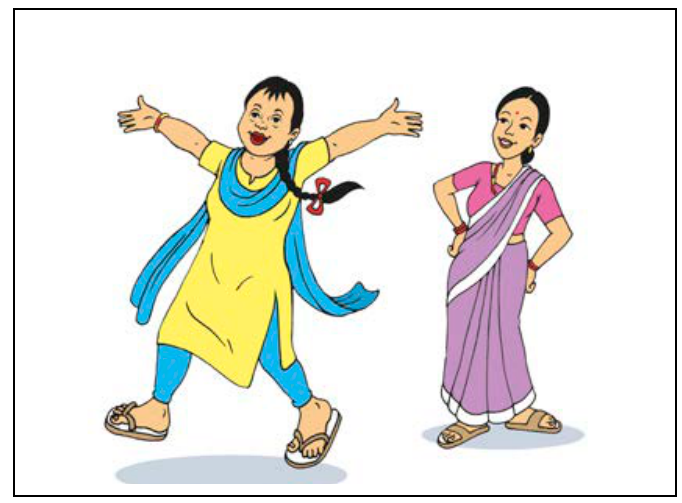
Figure 4. Bishesta and